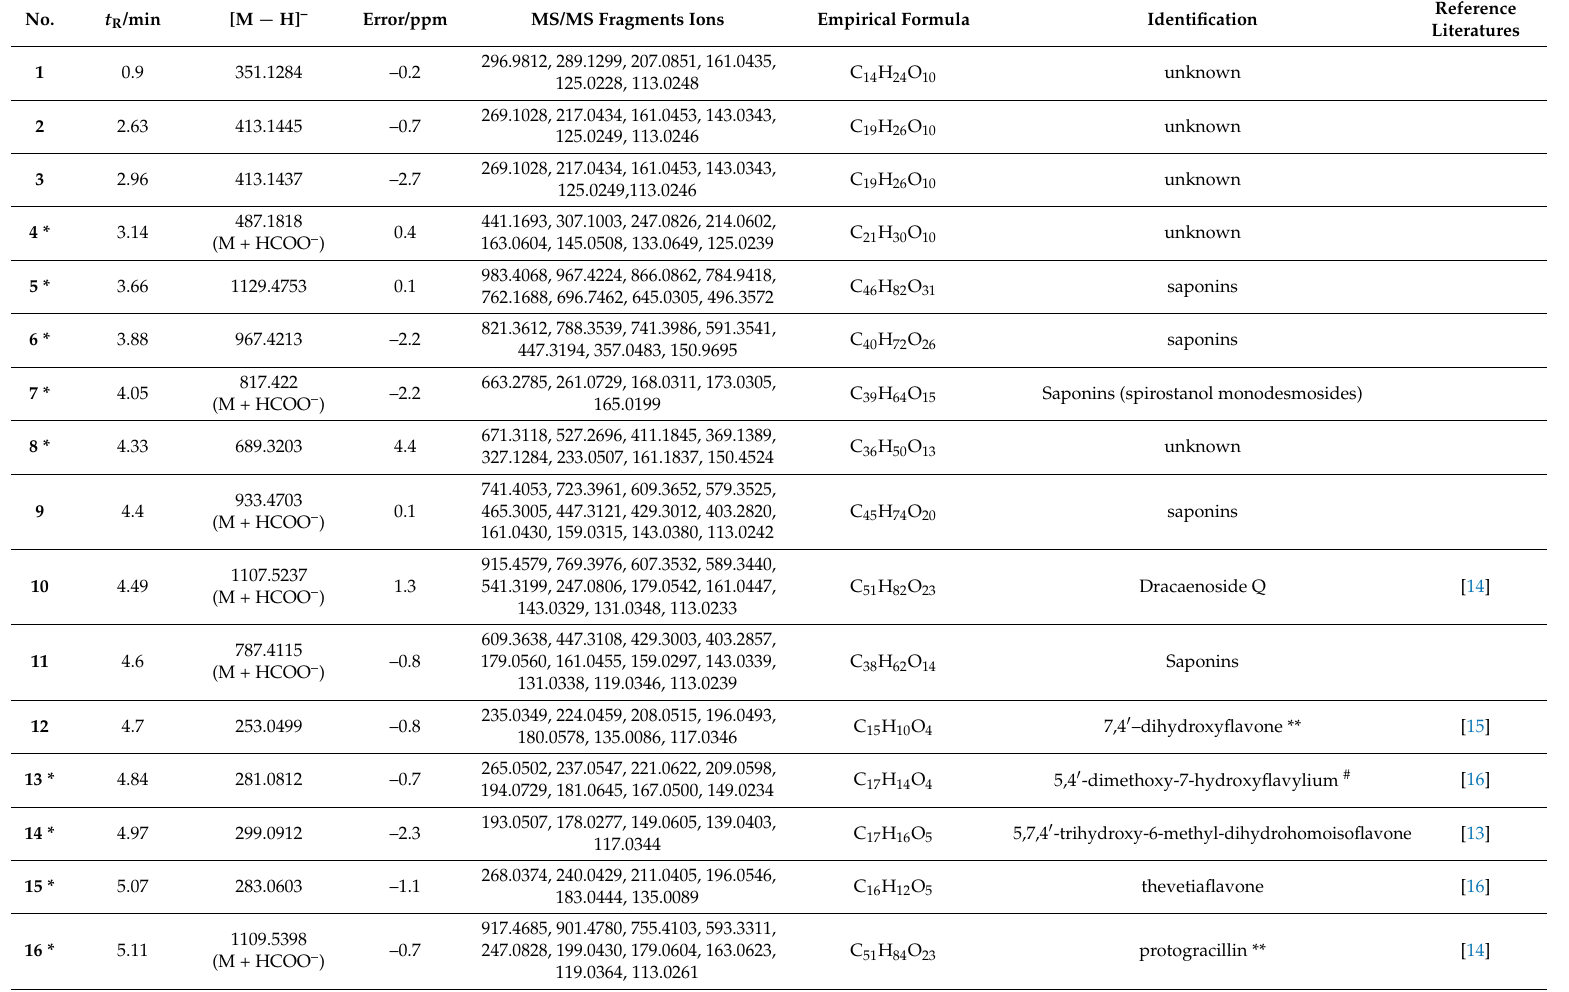
Table 1. Components identified from artificial induced Resina Draconis using